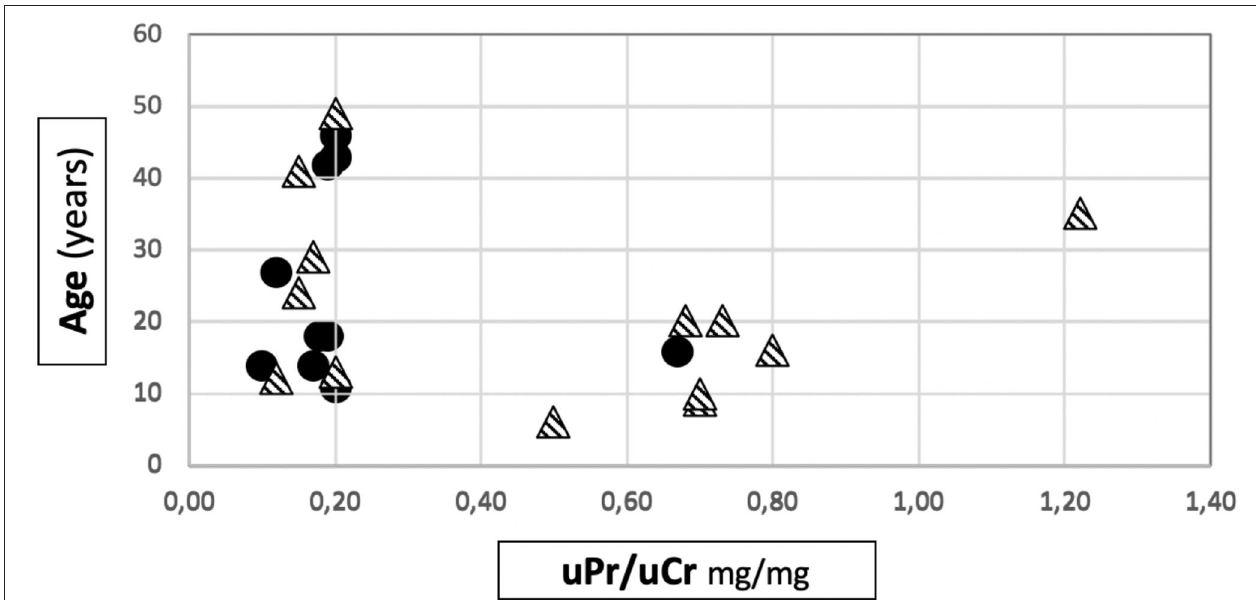
FIGURE 1 | Distribution of age to proteinuria correlation in our cohort. (cid:8) patients belonging to Group 1. patients belonging to Group 2.